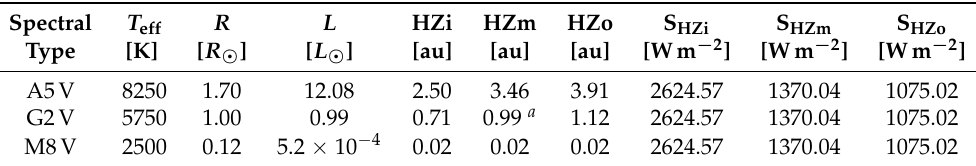
Table A1. Stellar parameters, exoplanet separations at inner, medium, and outer HZs, and corre- sponding irradiances.